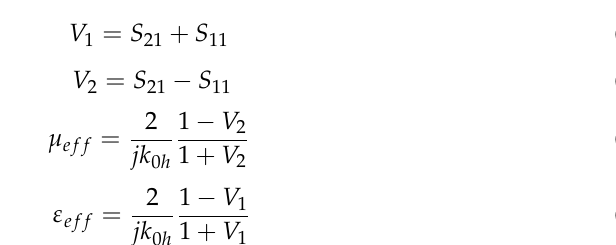
Figure 7. S-Parameter response of metallic-cross Unit-cell.